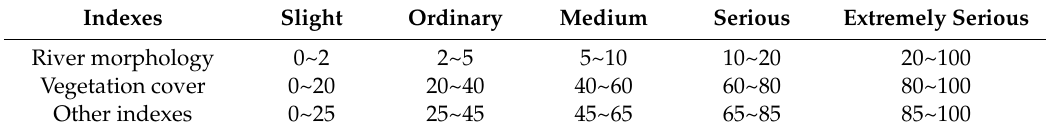
Table 1. Classifications and grades of environmental impact indexes of dam break.